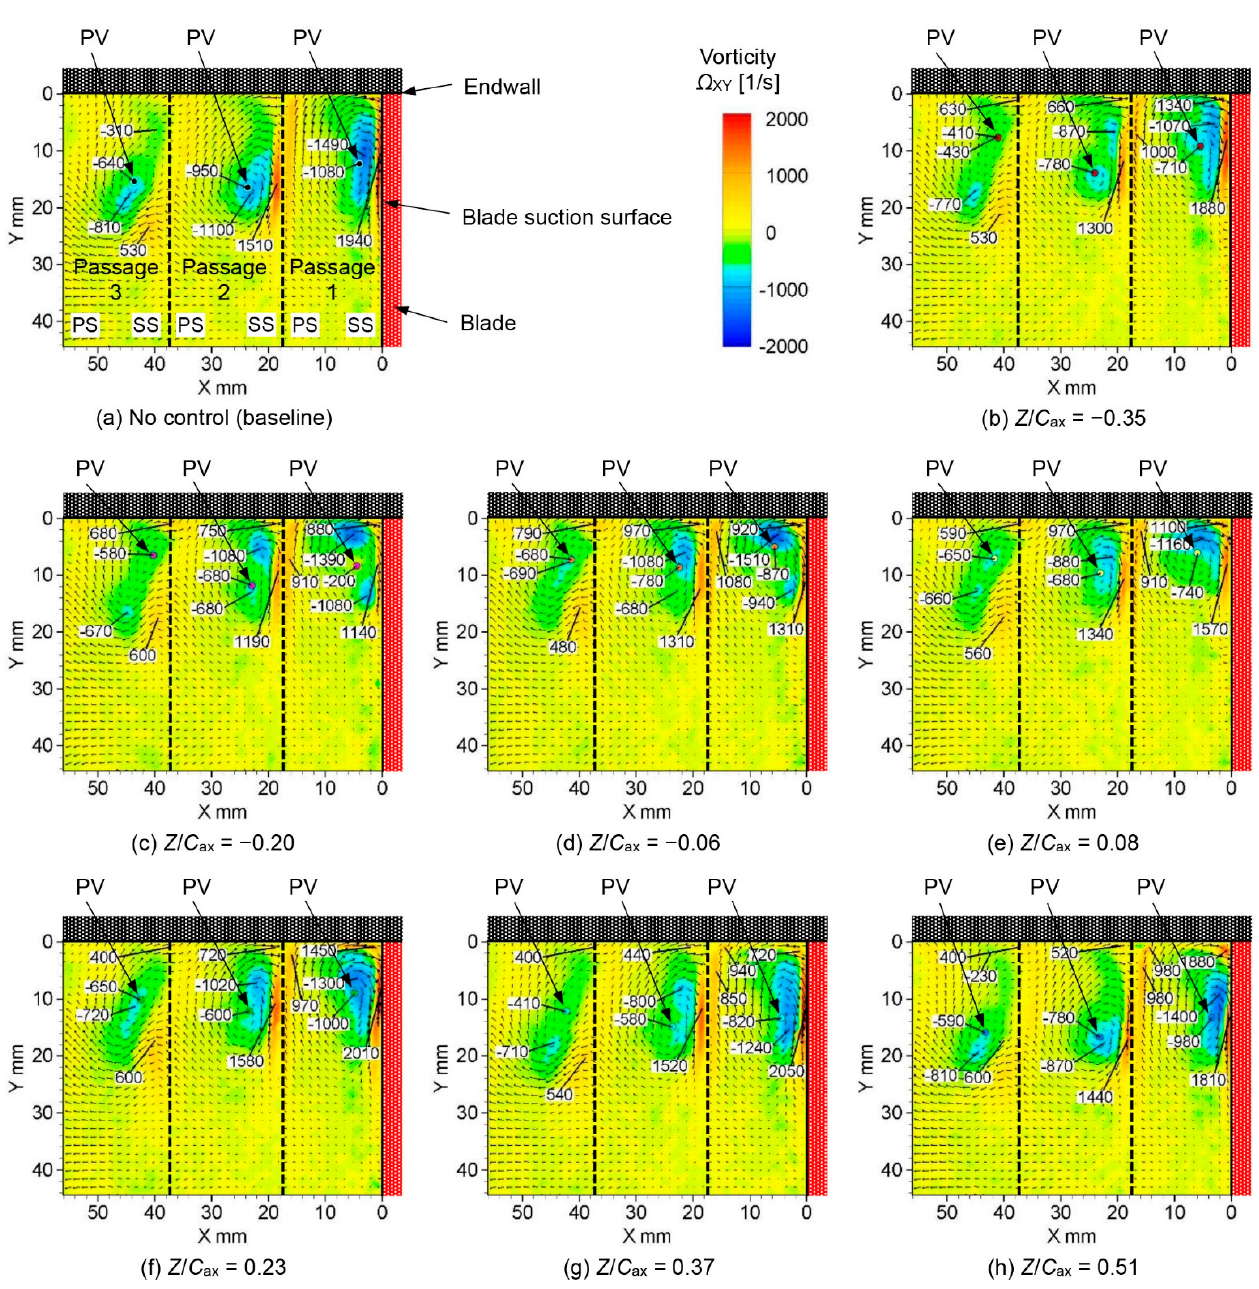
Figure 24. Vorticity distributions of secondary flow at the outlet of the linear turbine cascade at various plasma actuator locations (Re out = 3.7 × 10 4 ).